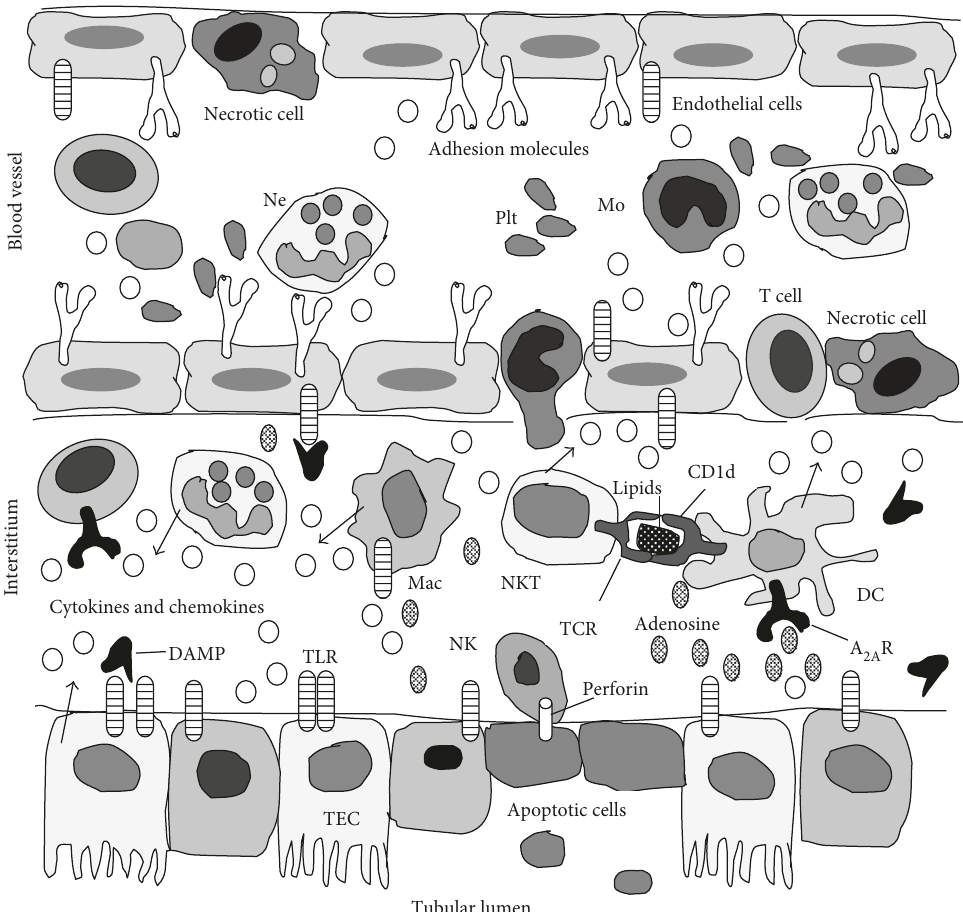
Figure 1: In fl ammation in kidney ischemia/reperfusion injury. During reperfusion, immune cells increase their adhesiveness and adhere to activated endothelium and some of them migrate into the interstitium, continuing the in fl ammation together with the resident renal immune cells, by secretion of numerous cytokines, chemokines, oxygen-free radicals, complement, and other mediators. Among other mediators there is adenosine that downregulates in fl ammation, acting via A R expressed on dendritic cells and T cells. A R: adenosine receptor; CD1d: 2A 2A glycoprotein presenting lipids and glycolipids to NKT; DAMP: danger-associated molecular patterns; DC: dendritic cell; Mac: macrophage; Mo: monocyte; Ne: neutrophil; NK: natural killer cell; NKT: natural killer T cell; Plt: platelet; TCR: T cell receptor; TEC: tubular epithelial cell; TLR: Toll-like